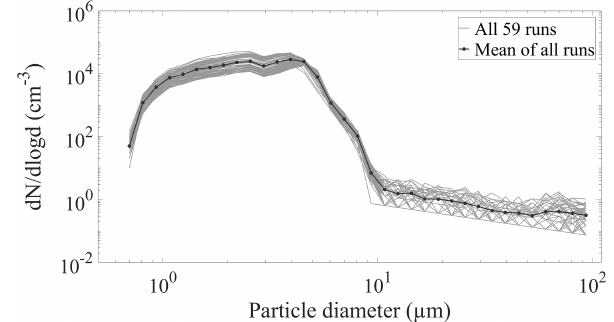
Figure 5. Particle size distribution for the same series of runs shown in Fig. 4.